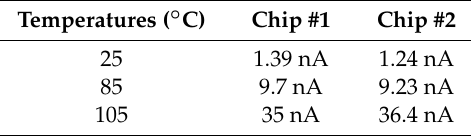
Table 4. Measured dark currents versus temperature of the proposed CAs, Chip #1 and Chip #2.